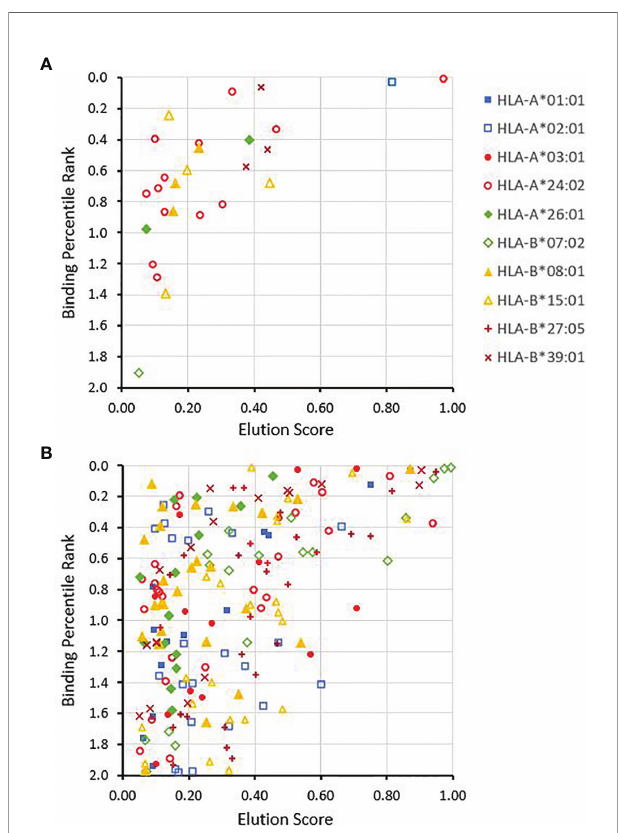
FIGURE 6 | Annotated noncoding regions containing recipient allele mismatch associations have open reading frames producing processed 8- 11mer processed peptides that contain the variant amino acid residue and are predicted to have promiscuous binding to a variety of HLA-A and B allotypes. Peptides originate from variants associated with (A) rs56040842 and (B) rs17811627. Peptides with elution scores <0.05 or percentile binding ranks >2.0 were